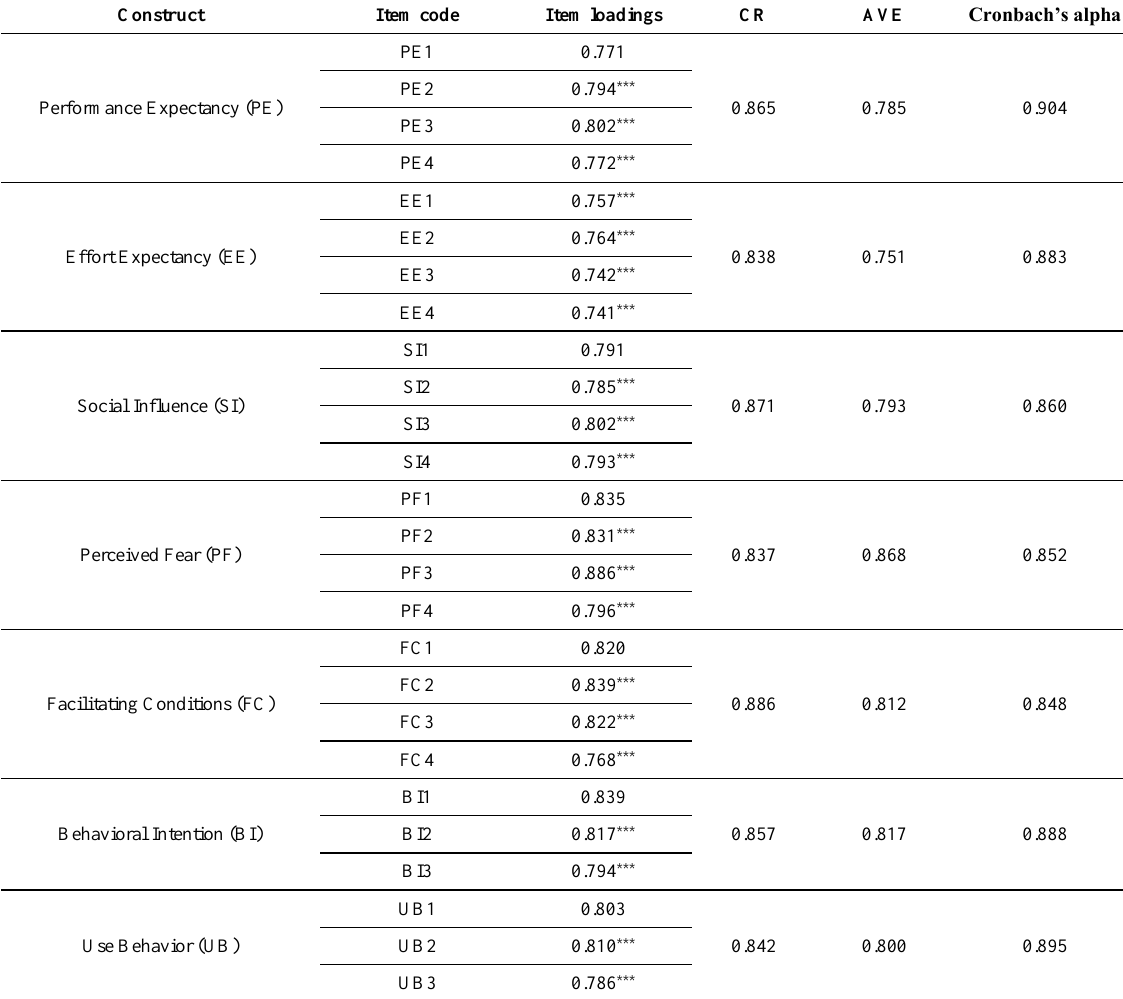
Table 3. Factor loadings, composite reliability (CR), average variance extracted (AVE), and Cronbach’s